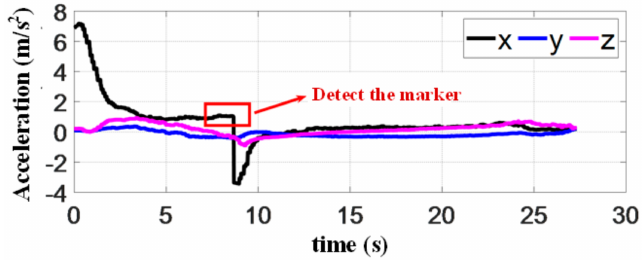
Figure 24. Acceleration of the quadrotor in the experiment.